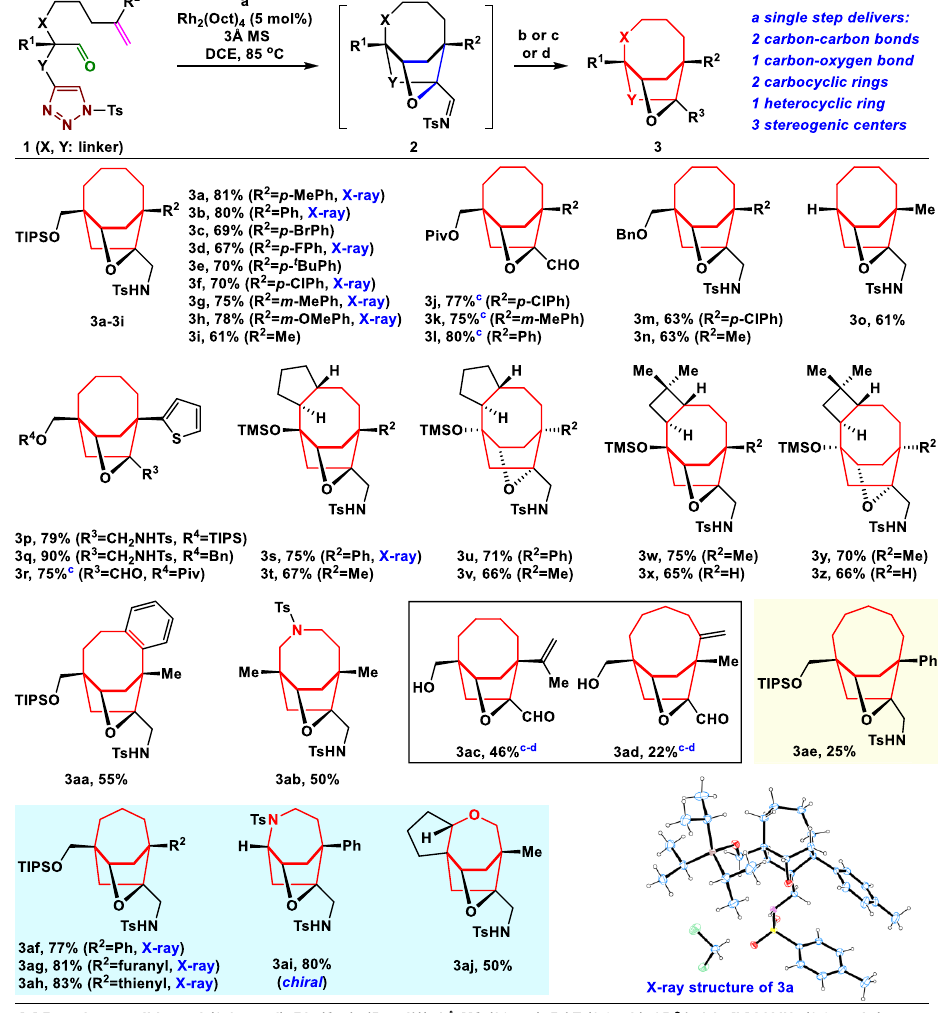
Fig. 2 Substrate scope. Rhodium-catalyzed type II (3 + 2) cycloaddition reaction using various substrates to give highly functionalized bridged medium- sized ring systems. Bn benzyl, Piv pivaloyl, TMS